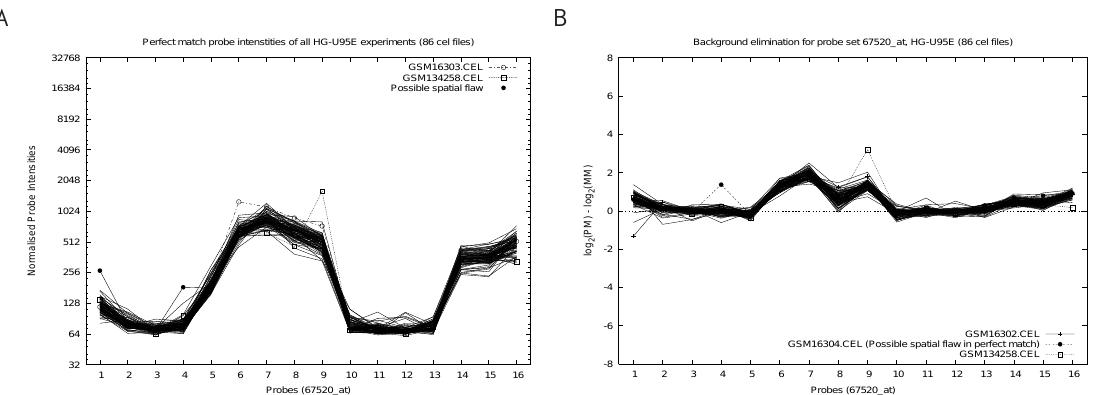
Figure 5: Probe intensities over all cel files for probe set 67520 at on the HG U95E array (A) Perfect match intensities (log scale) (B) Background elimination (log 2 (PM) - log 2